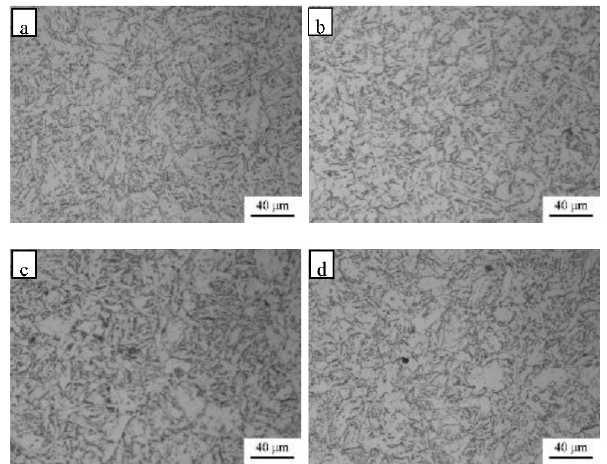
Figure 4. Typical optical micrographs associated with the matrix microstructures of samples containing ( a ) 0.15 wt.% Si, ( b ) 0.36 wt.% Si, ( c ) 0.48 wt.% Si, and ( d ) 0.77 wt.% Si.